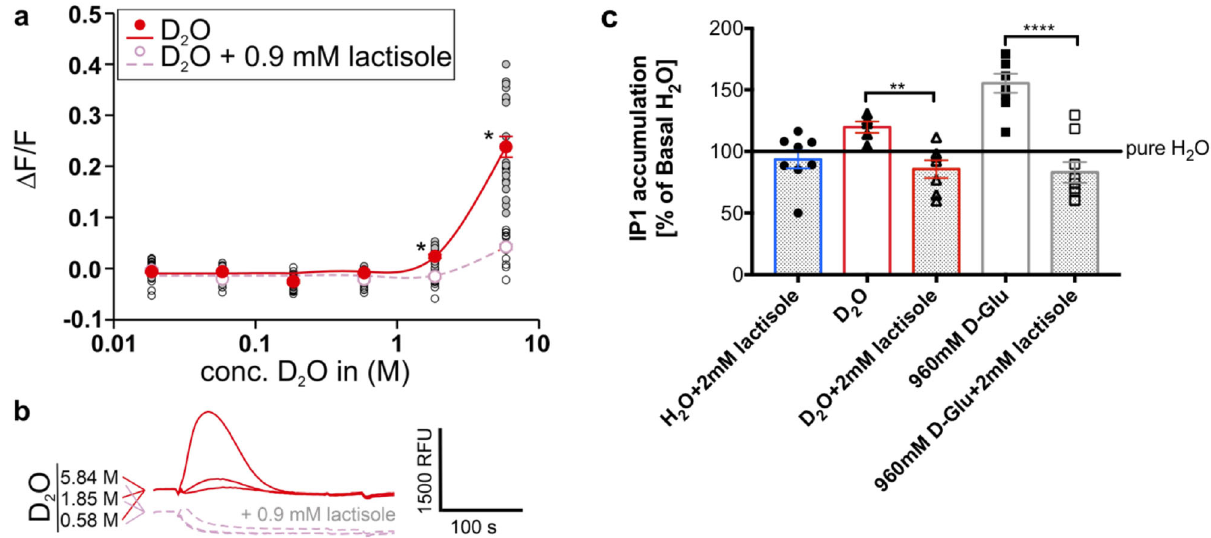
Fig. 5 D 2 O-activation of the human sweet taste receptor. a Dose – response relationship of cells expressing the human sweet taste receptor and treated with different concentrations of D 2 O ( fi lled red circles, red line). Cells treated with lactisole served as negative controls (open pink circles, pink line). y axis, relative changes in fl uorescence upon stimulus application ( Δ F / F ). x axis, logarithmically scaled molar D 2 O-concentrations. Asterisks indicate fl uorescence changes above baseline signi fi cantly different from lactisole-treated controls ( p ≤ 0.01). b Raw fl uorescence traces of D 2 O-treated (red-traces, top) and D 2 O + 0.9 mM lactisole-treated cells (pink-traces, bottom) stimulated with the indicated D 2 O-concentrations. A scale bar indicating relative fl uorescence (relative fl uorescence units (RFU) and experimental time (in seconds (s)) is included. c Lactisole inhibitory effect on D 2 O-activation of the human sweet taste receptor using an IP1 assay. Cells treated with D-glucose served as positive controls. On y axis, relative changes in IP1 accumulation upon stimulus application are shown as % of basal – pure H 2 O. x axis, different ligands, with and without lactisole. Asterisks indicate IP1 changes that are signi fi cantly different from lactisole-treated controls (** p ≤ 0.005 and **** p ≤ 0.0001) using t